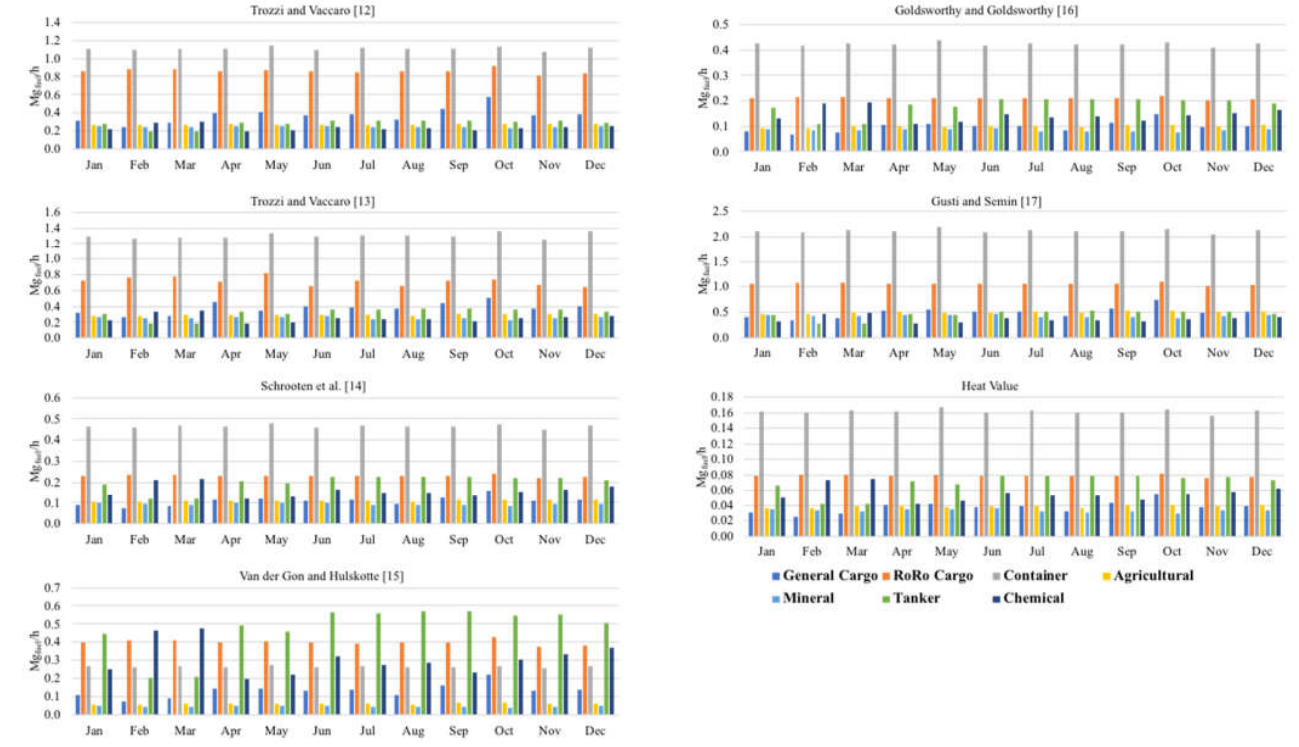
Figure 10. Monthly average fuel consumption (Mg fuel /h) for each type of vessel and method.